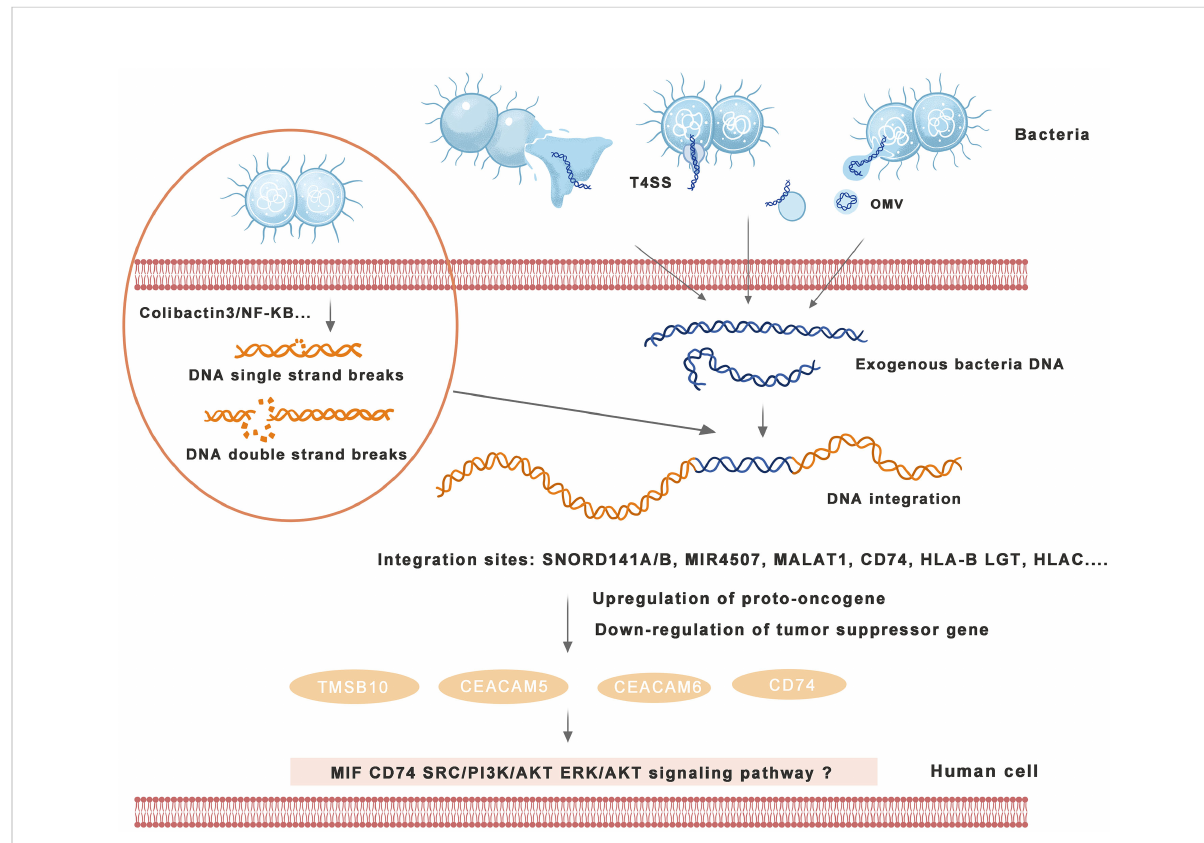
FIGURE 2 Mechanism of bacterial DNA integration into the human genome and induction of cancers. Bacteria excrete DNA through direct exclusion, outer membrane vesicle (OMV) excretion, type IV secretion system (T4SS), etc., and human cells receive exogenous DNA with transformation ability. Bacteria can induce human DNA single-strand breaks (SSBs) or double-strand breaks (DSBs) through a variety of signaling pathways, providing conditions for DNA integration into the human genome. Human cells integrate exogenous bacterial DNA into the exon or intron region and activate carcinogenic signaling pathways and induce tumors by enhancing proto-oncogene expression or weakening tumor suppressor gene expression in the human